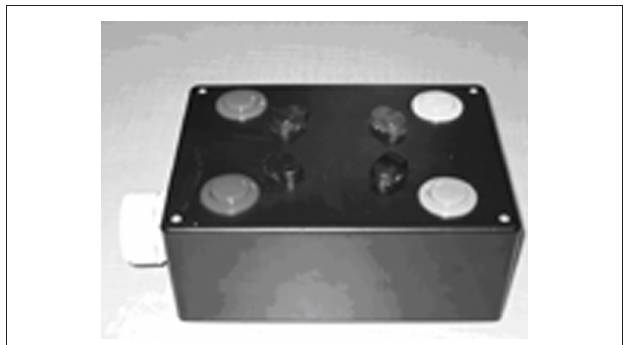
Figure 1 | The lightbox used in the procedure. The four buttons, colored red, yellow, green, and blue, activated their corresponding light for as long as the button was